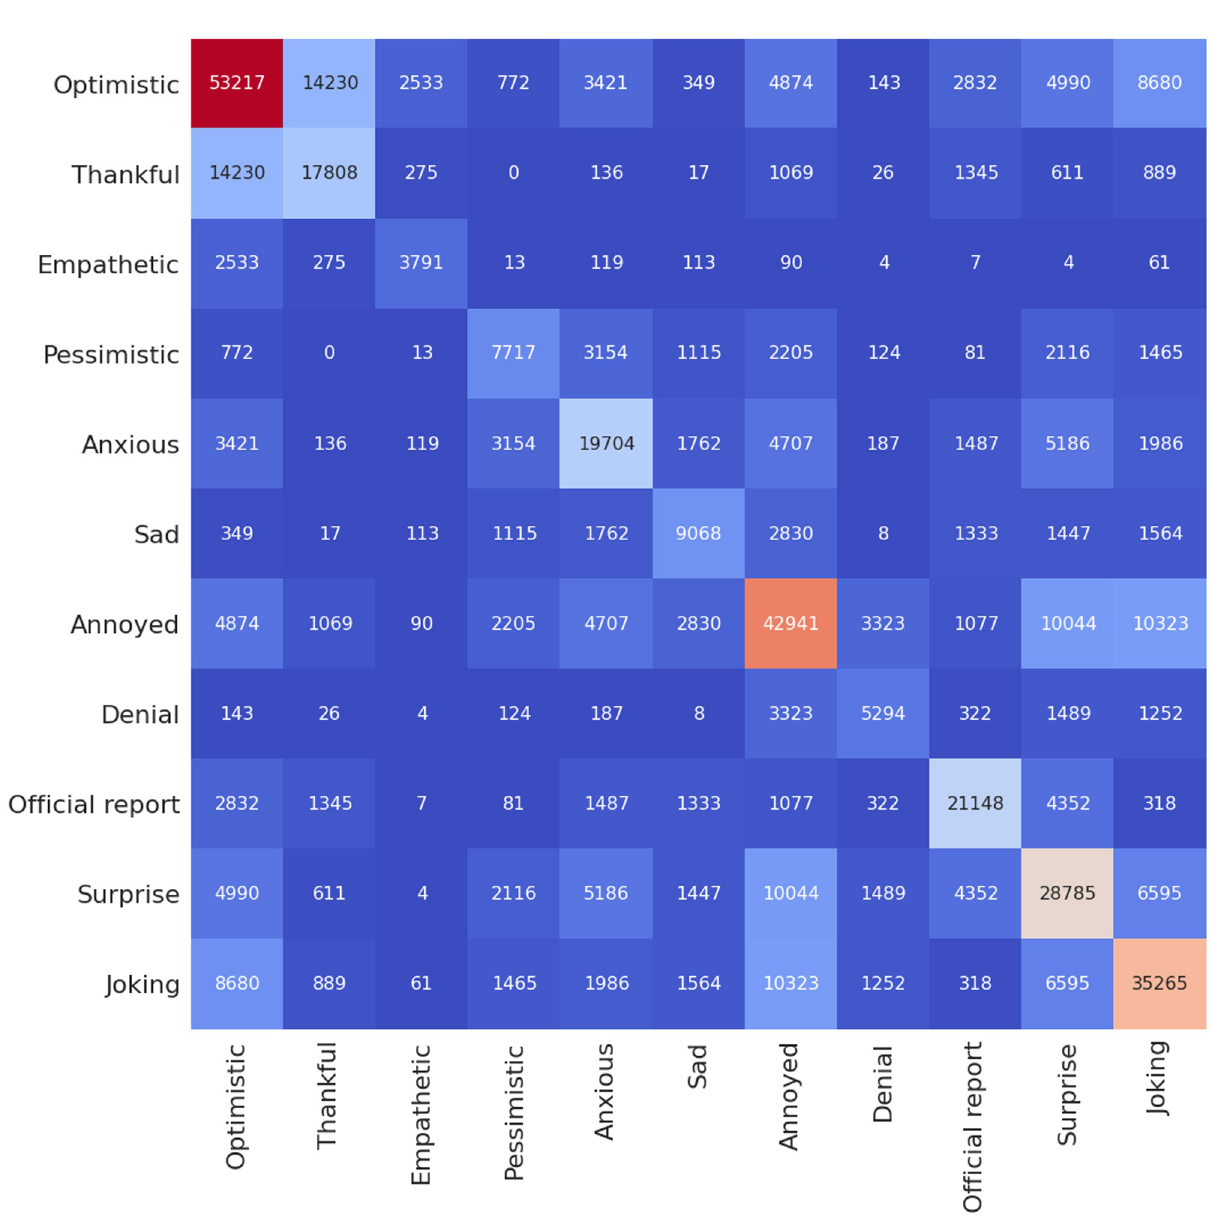
Fig 6. Heatmap showing number of occurrence of a given sentiment in relation to the rest of the sentiments for the India dataset using the BERT